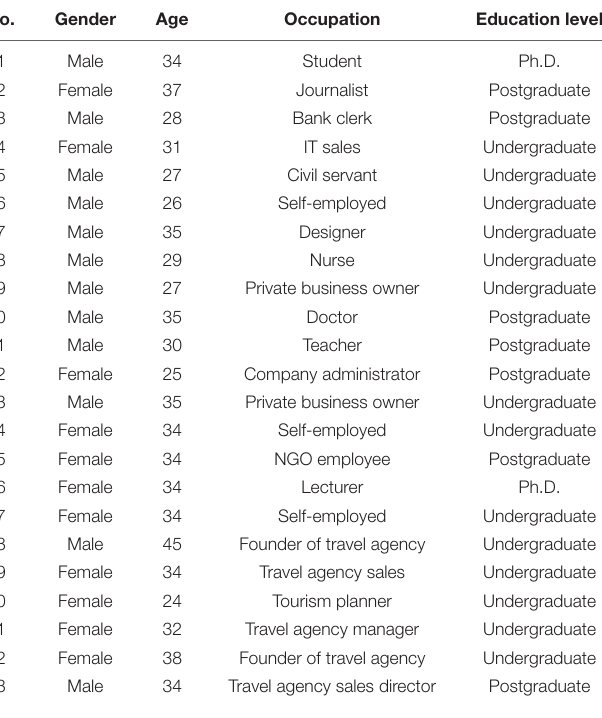
TABLE 1 | Profile of interviewees for